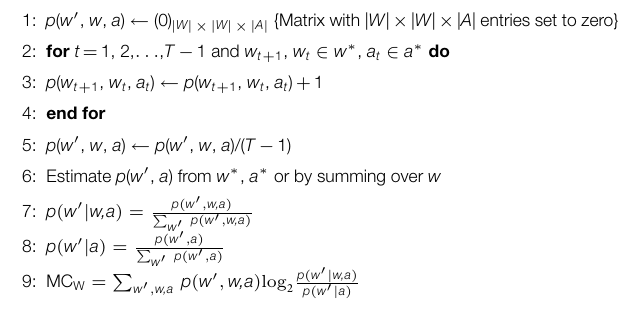
ALGORITHM 2 | Algorithm for MC W .